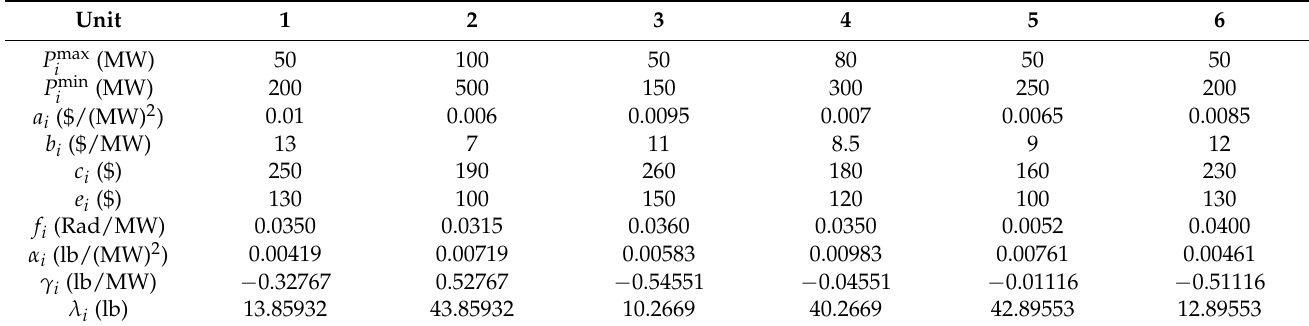
Table A1. Generator characteristics.